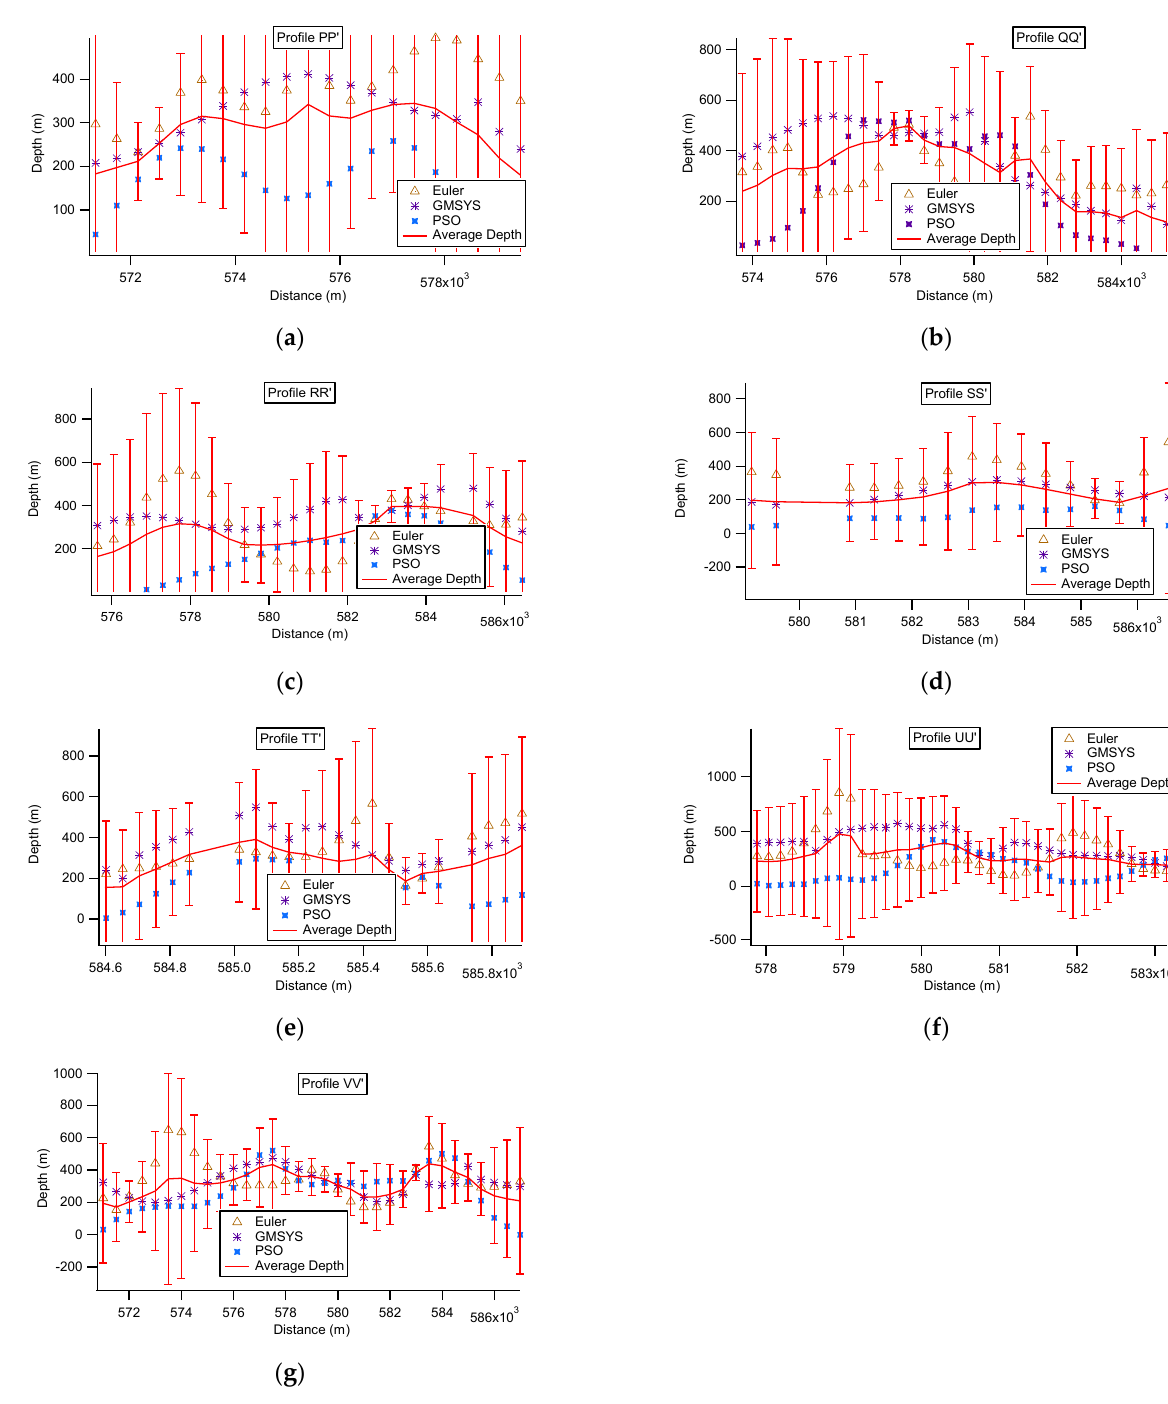
Figure 15. The graphical plot for the comparison of the depths from the three methods (Euler, GMSYS, and PSO). ( a ) Graphical depth plots for Profile PP’. ( b ) Graphical depth plots for Profile QQ’. ( c ) Graphical depth plots for Profile RR’. ( d ) Graphical depth plots for Profile SS’. ( e ) Graphical depth plots for Profile TT’. ( f ) Graphical depth plots for Profile UU’. ( g ) Graphical depth plots for Profile VV’.